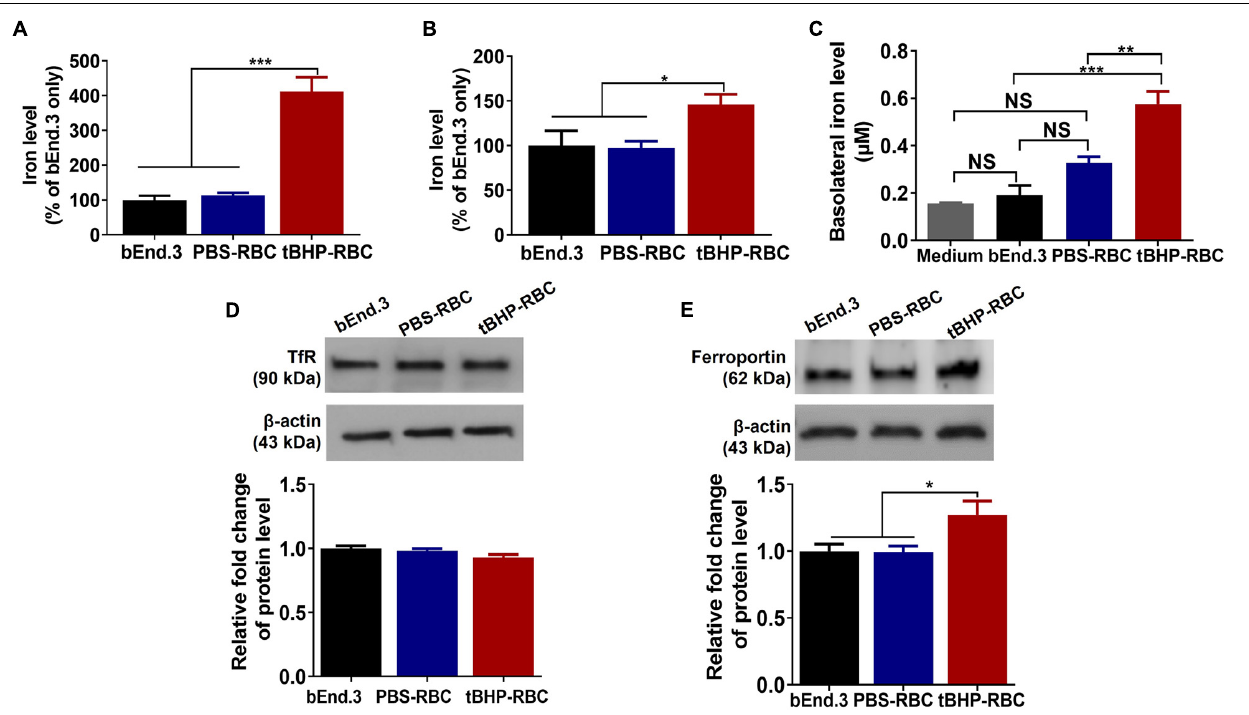
FIGURE 6 | Brain endothelial erythrophagocytosis increased cellular iron load and abluminal iron. Significant increase in total cellular iron (iron from attached and engulfed RBCs) (A) and intracellular iron (iron from engulfed RBC) (B) in bEnd.3 cells following a 48-h incubation with tBHP-RBCs. Significant increase in basolateral iron levels after the 48-h incubation with tBHP-RBCs (C) . No change in the levels of iron importer, transferrin receptor (TfR) (D) , but an increase in the levels of iron exporter, ferroportin (E) , in bEnd.3 cells after the 48-h incubation with PBS- or tBHP-RBCs. Data are presented as mean ± SEM of three independent experiments done in duplicates. One-way ANOVA with Holm–Sidak post hoc test was used. * p < 0.05, ** p < 0.01, *** p < 0.001. NS is “not